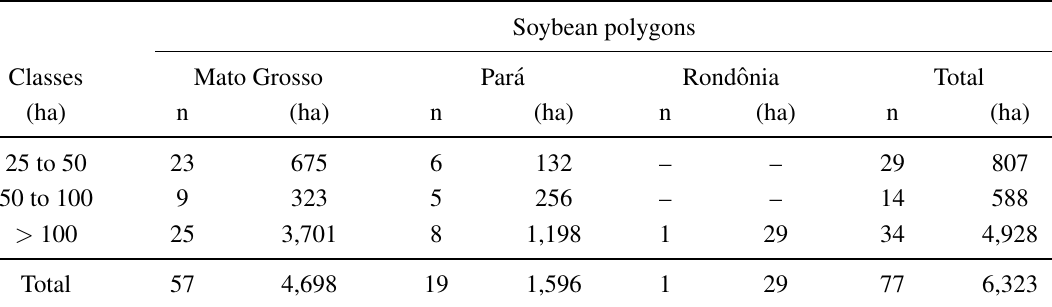
Table 6. Number of polygons (n) and area (ha) with soybean identified during aerial survey, by classes of deforested polygon size, in the states of Mato Grosso, Par ´ a and Rond ˆ onia. Soybean polygons Classes Mato Grosso Par ´ a Rond ˆ onia Total (ha) (ha) n